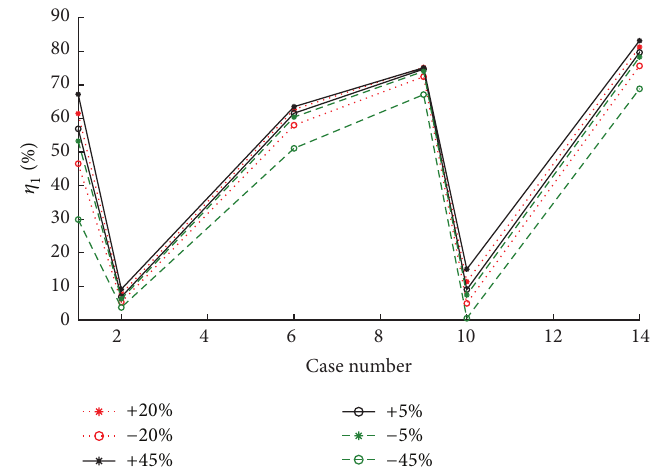
Figure 25: 𝜂 1 for different cases of Table 5 and values of bias on 𝜉 𝑝 (bias on 𝜔 𝑝 equal to +2%).